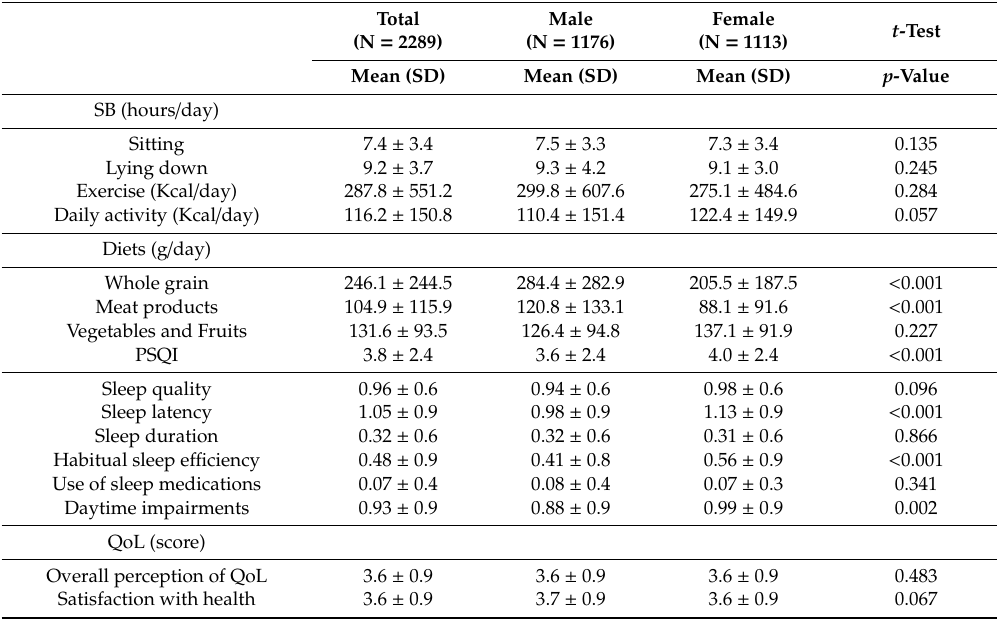
Figure 2. Proportion of people participating in physical activity (PA) during the home-isolation period. ( A ) Frequency of participation in di ff erent exercises. ( B ) Duration of participation in di ff erent exercises per time. ( C ) Frequency of participation in di ff erent daily physical activities. ( D ) Duration of participation in daily activities per time. Table 2. Comparison of physical activity, food consumption, sleep, and quality of life between men and